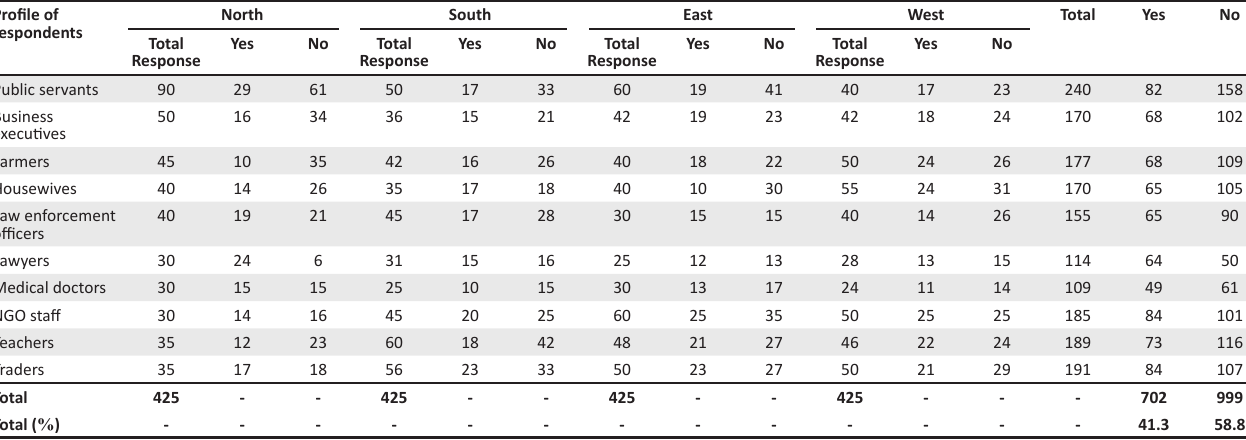
TABLE 1: Nature of political leadership ethical credibility. Profile of